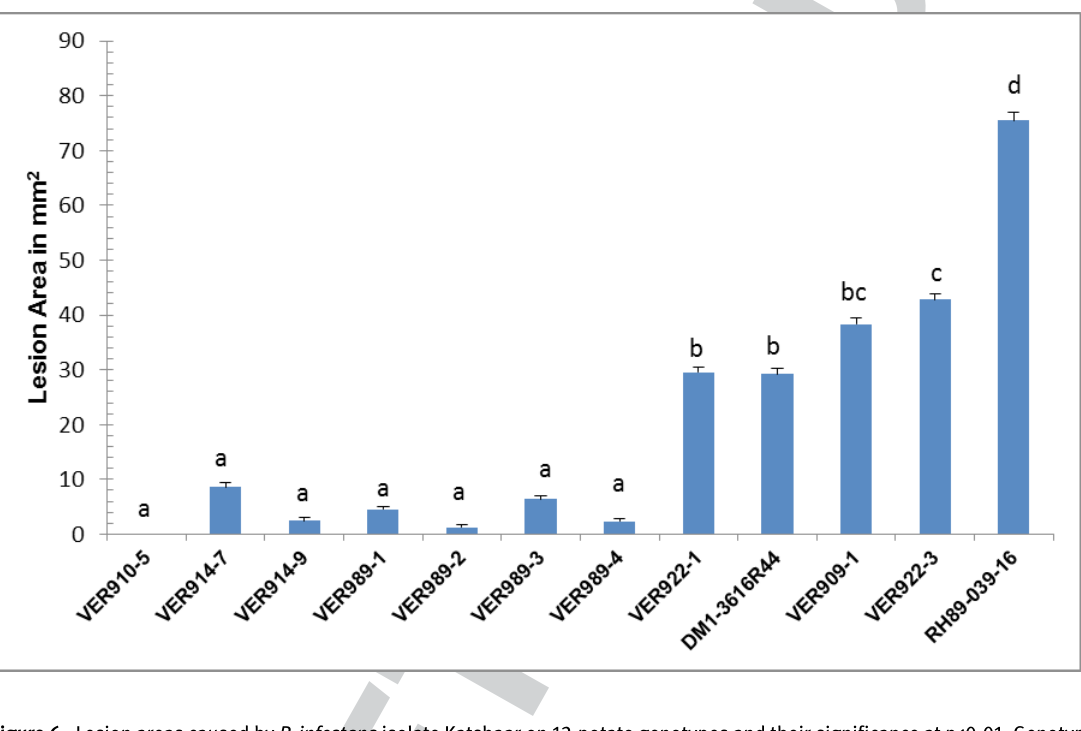
Figure 6. Lesion areas caused by P. infestans isolate Katshaar on 12-potato genotypes and their significance at p<0.01. Genotypes that have similar letter are not significantly different and vice versa